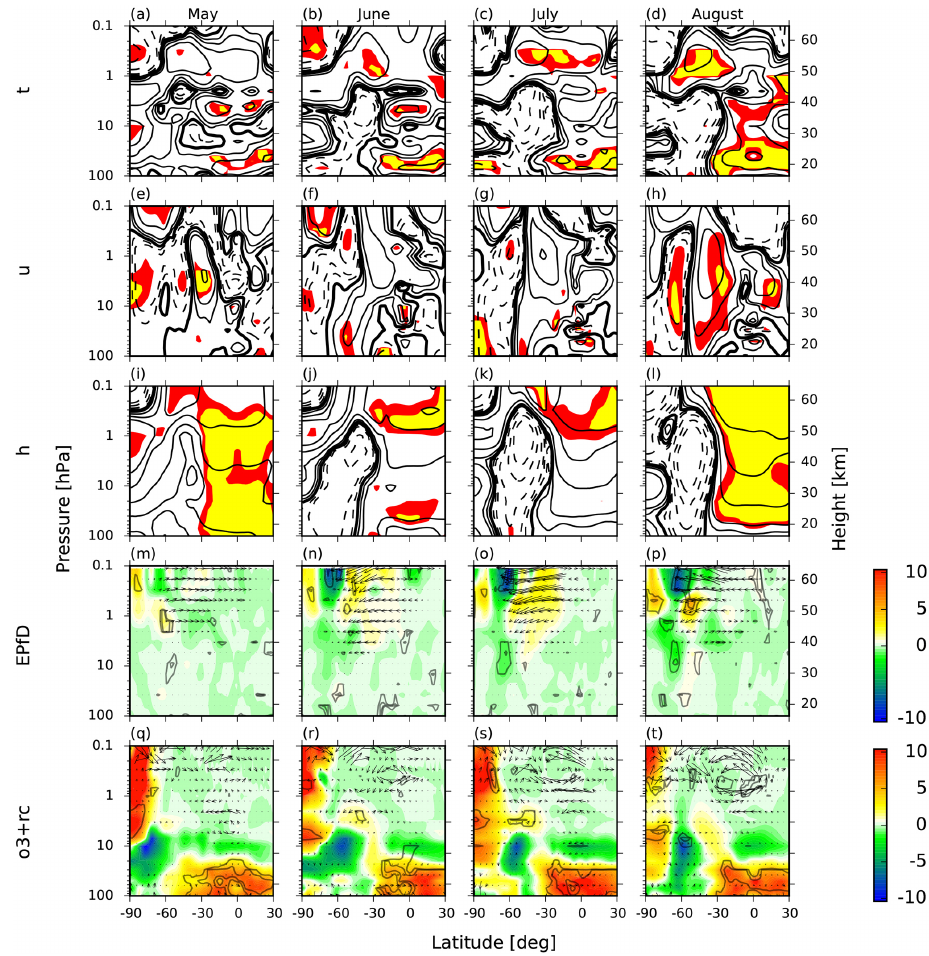
Figure 6. The monthly averaged response of the solar signal in the MERRA zonal-mean temperature t (a–d) ; unit: K; contour levels: 0, ± 0 . 25, ± 0 . 5, ± 1, ± 2, ± 5, ± 10, ± 15, ± 30; zonal wind u (e–h) , unit: ms − 1 ; contour levels: 0, ± 1, ± 2, ± 5, ± 10, ± 15, ± 30; geopotential height h (j–l) ; unit: gpm; contour levels: 0, ± 10, ± 20, ± 50, ± 100, ± 150, ± 300; EP flux divergence EPfD (m–p) , unit: ms − 1 day − 1 ; together with EP flux vectors scaled by the inverse of the pressure; unit: m 2 s − 2 ; and ozone mixing ratio, unit: percentage change per monthly mean; with residual circulation o 3 + rc (q–t) ; units: ms − 1 , − 10 − 3 Pas − 1 during southern hemispheric winter. The response is expressed as a regression coefficient (corresponding units per S max minus S min ). The statistical significance of the scalar fields was computed by a t test. Red and yellow areas in Panels (a–l) and grey contours in Panels (m–t) indicate p values of < 0.05 and 0.01